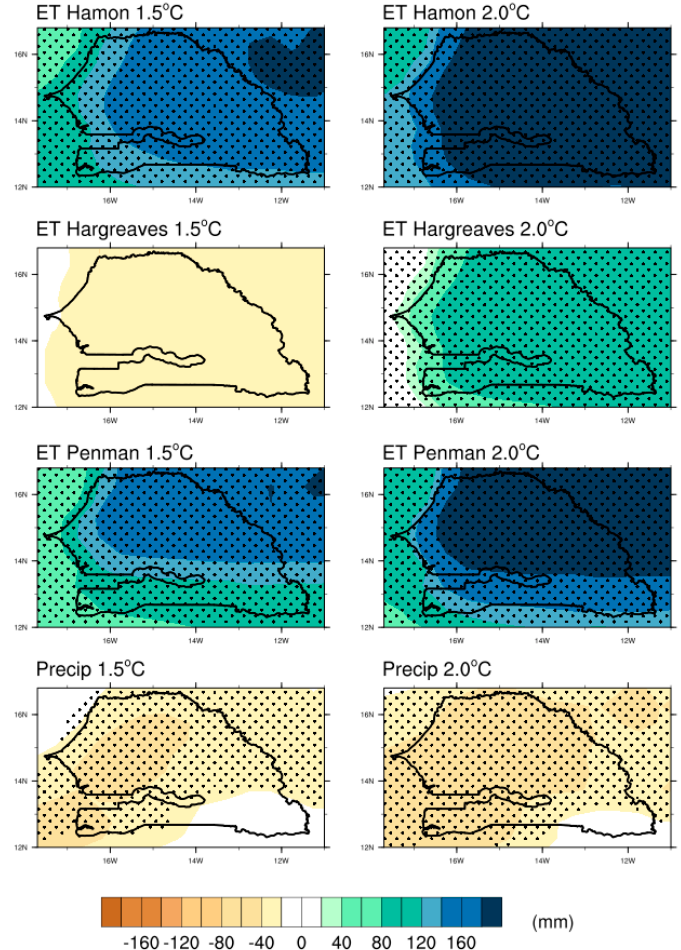
Figure 2. Annual evapotranspiration (ET, first row: Hamon, second row: Hargreaves, third row: Penman) and precipitation (Precip, fourth row) changes under 1.5 °C ( left column ) and 2 °C ( right column ) GWLs. Statistically significant changes (Student’s t -test) at 95% confidence level are represented by black dots.